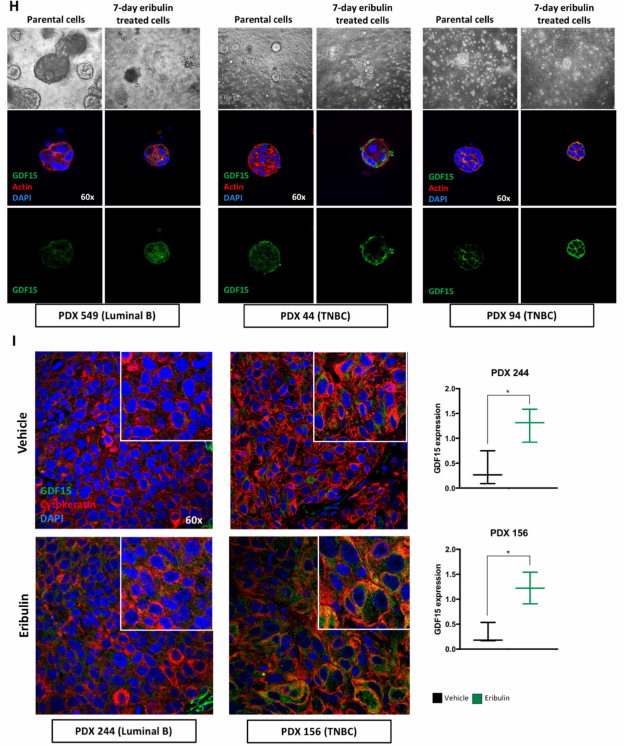
Figure 4. GDF15 secretion is strongly associated with DTP cells. ( A ) WB analysis of GDF15 protein in the vehicle and 1.5 nM eribulin cell lysates and secretome collected at different time points during a 30-day treatment in MDA-MB-231 and MCF7 cell lines. ( B ) WB analysis of GDF15 protein in secretome collected from 7-day vehicle (parental), 7-day 1.5 nM eribulin (DTP) and 30-day 1.5 nM eribulin (drug-resistant)-treated MDA-MB-231 and MCF7 cells. ( C ) Left: WB analysis of GDF15 protein in secretome collected from 7-day vehicle (parental), 7-day 1.5 nM eribulin (DTP) and 30-day 1.5 nM eribulin (Non-fully drug-resistant)-treated MCF10A (non-malignant) cells. Right: Representative confocal images of GDF15 (green) and Actin (red) immunofluorescence in 3D cell-cultured MCF10A (non-malignant) cells following treatment with vehicle and 1.5 nM eribulin for 7 days. Nuclei were stained with DAPI. One representative experiment is shown. ( D ) Representative cell pictures of the different cell states: parental, DTP and drug-resistant/non-fully drug-resistant. ( E ) WB analysis of GDF15 in the secretome collected from MCF7 cells in the following treatment conditions: 7-day vehicle (parental) treated, 7-day 1.5 nM eribulin (DTP) treated, 7-day 1.5 nM eribulin-treated cells pre-treated for 7 days more with eribulin (Continued treatment) and 7-day 1.5 nM eribulin-treated cells propagated for 7 days in drug-free media (Drug holiday). ( F ) Schematic representation of eribulin treatment and secretome collection in 3D cell culture. ( G ) WB analysis of GDF15 protein in secretome collected from 3D cell-cultured MDA-MB-231 and MCF7 following treatment with vehicle and 1.5 nM eribulin for 7 days. Representative confocal images of GDF15 (green) and Actin (red) immunofluorescence in 3D cell-cultured MDA-MB-231 and MCF7 cells following treatment with vehicle and 1.5 nM eribulin for 7 days. Nuclei were stained with DAPI. One representative experiment is shown. ( H ) Cellular images (upper panel) and confocal images of GDF15 (green) and Actin (Red) (lower panel) in two representative breast cancer PDX models treated for 7 days with vehicle and 1.5 nM eribulin in a 3D cell culture system. ( I ) Representative confocal images of GDF15 (green) staining in breast cancer tissues derived by PDX tumor cells treated with eribulin in vivo for a month. Staining for human-cytokeratin (red) allowed for discrimination of human epithelial cells from other cell components. Nuclei were stained with DAPI. Graphs show quantification of GDF15 (green) staining intensity normalized to number of cells (DAPI discrimination. Minimum of 150 cells in three different regions of interest). * p -value <